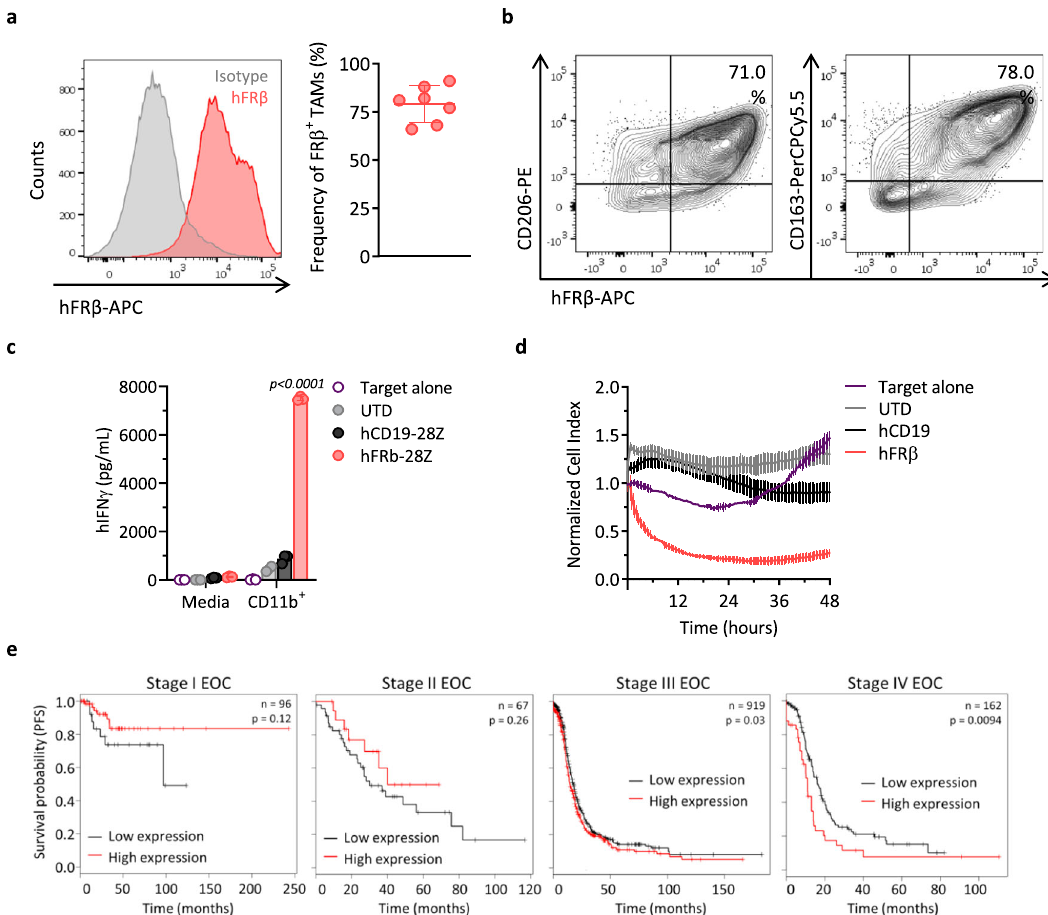
Fig. 7 Ovarian cancer TAMs highly express FR β and are targeted by human FR β CAR-T cells. a hFR β expression in TAMs obtained from the ascites of ovarian cancer patients as assessed by fl ow cytometry. Representative histogram (gray — isotype, red — anti-hFR β , left panel) and mean frequency of FR β + TAMs (de fi ned as live, CD45 + CD11b + CD14 + cells, right panel) ± SD are shown ( n = 7 ascites biospecimens). b Representative fl ow plots showing coexpression of hFR β ( X -axis) and the surface markers CD206 (left panel) and CD163 (right panel, Y -axis) in ovarian cancer patient TAMs. Overnight cocultures of hFR β CAR, hCD19 CAR, or UTD T cells with CD11b + cells isolated from the ascites of ovarian cancer patients were established at a 1:1 E:T ratio. c Levels of secreted hIFN- γ as detected by ELISA in the supernatants. P values by a two-way ANOVA with Tukey ’ s multiple comparison test